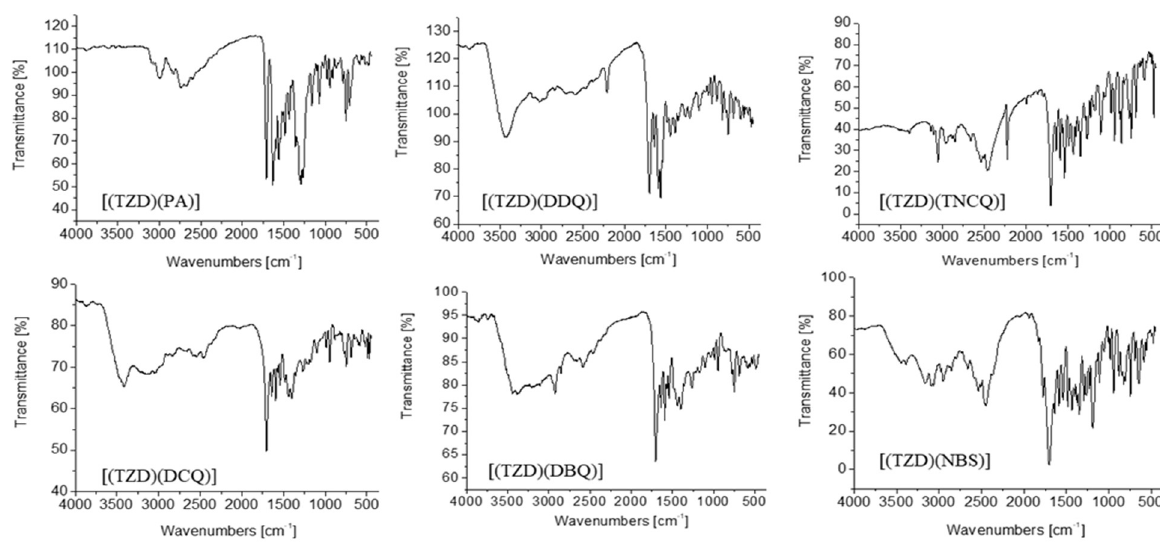
Figure 4. IR spectra of the ligand-acceptors complexes.